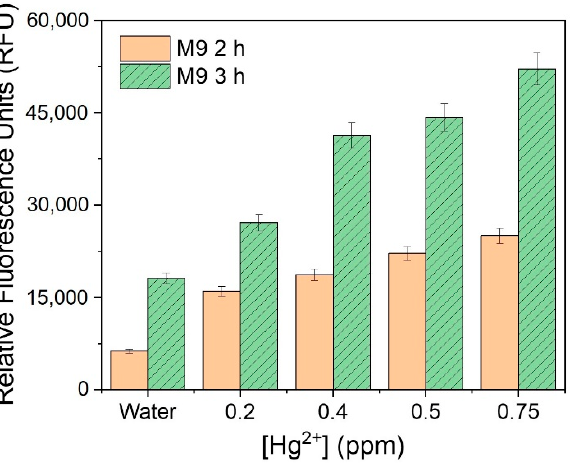
Figure 5. Comparison of relative fluorescence units value according to incubation time in the M9 media.